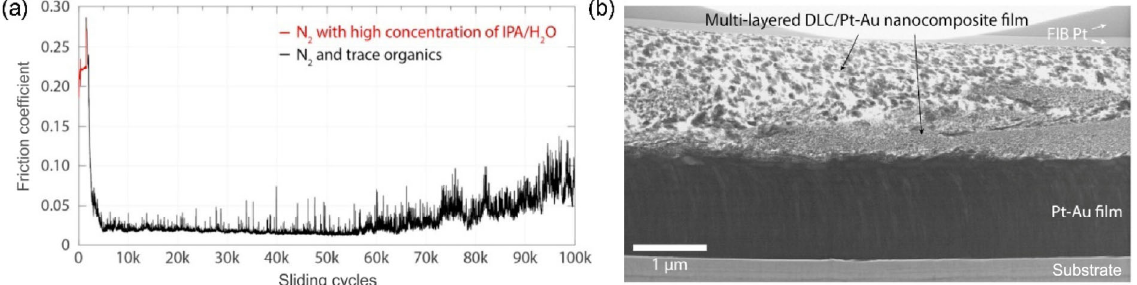
Fig. 1 (a) Wear-resistant Pt − Au alloy surface lubricated from ambient trace hydrocarbons in dry N 2 , (b) the in situ tribochemically formed self-lubricating DLC/Pt − Au nanocomposite film. Reproduced with permission from Ref. [3]. © Elsevier,